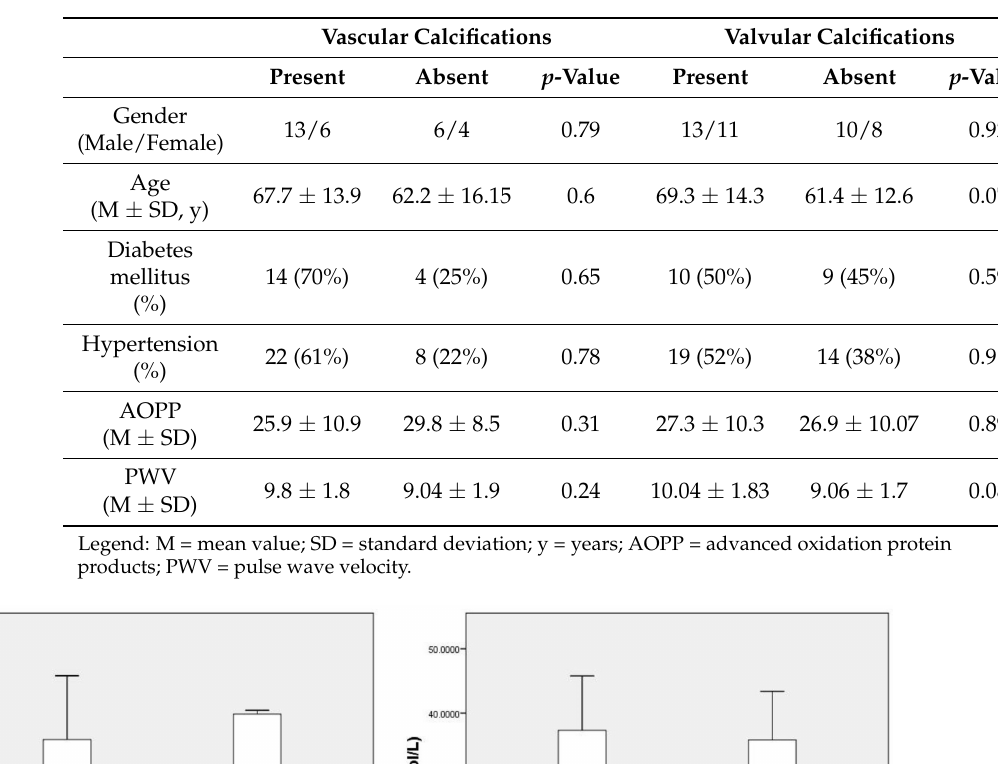
Table 2. Patients’ characteristics outlined according to the presence/absence of vascular or valvular calcifications.